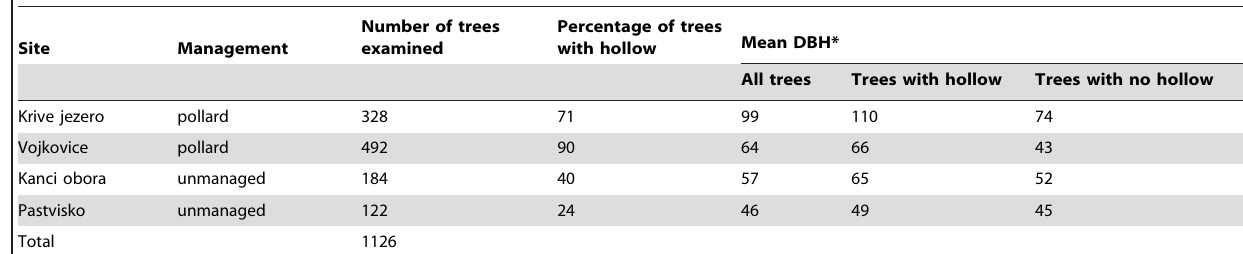
Table 1. Collected data on willows.